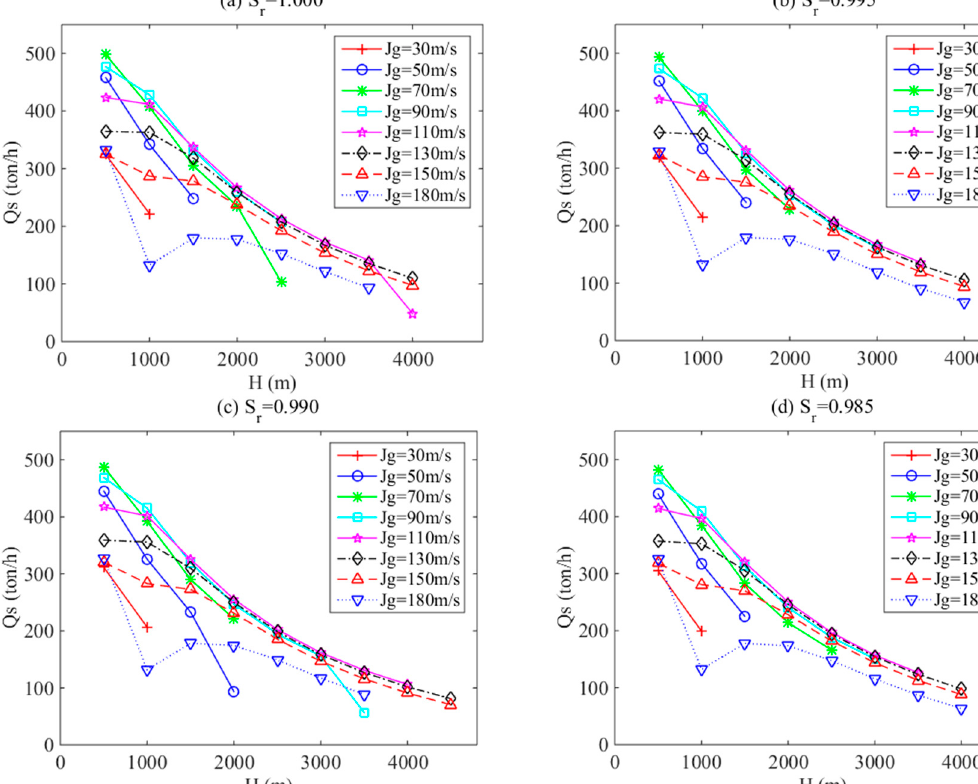
S at different r